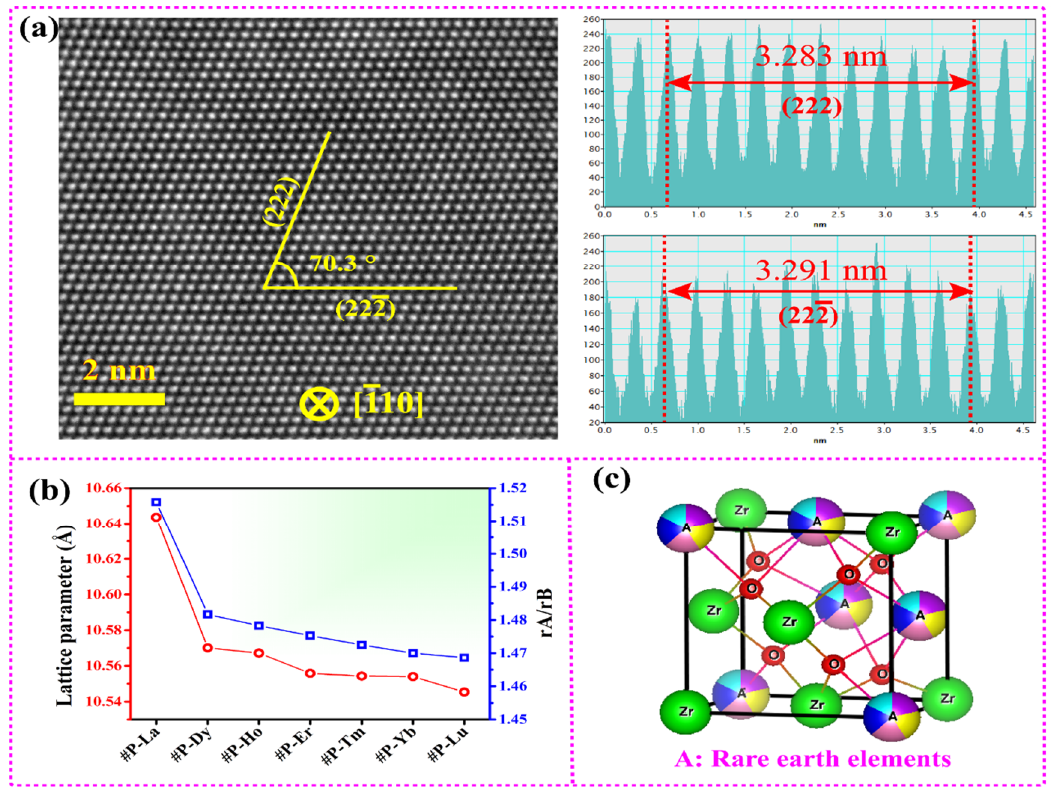
Figure 3. ( a ) HR-TEM images of #P-La. ( b ) The ionic radius ratio and the lattice parameter of compounds #P-La~Lu. ( c ) The schematic diagram of the ideal high-entropy pyrochlore structure using VESTA.